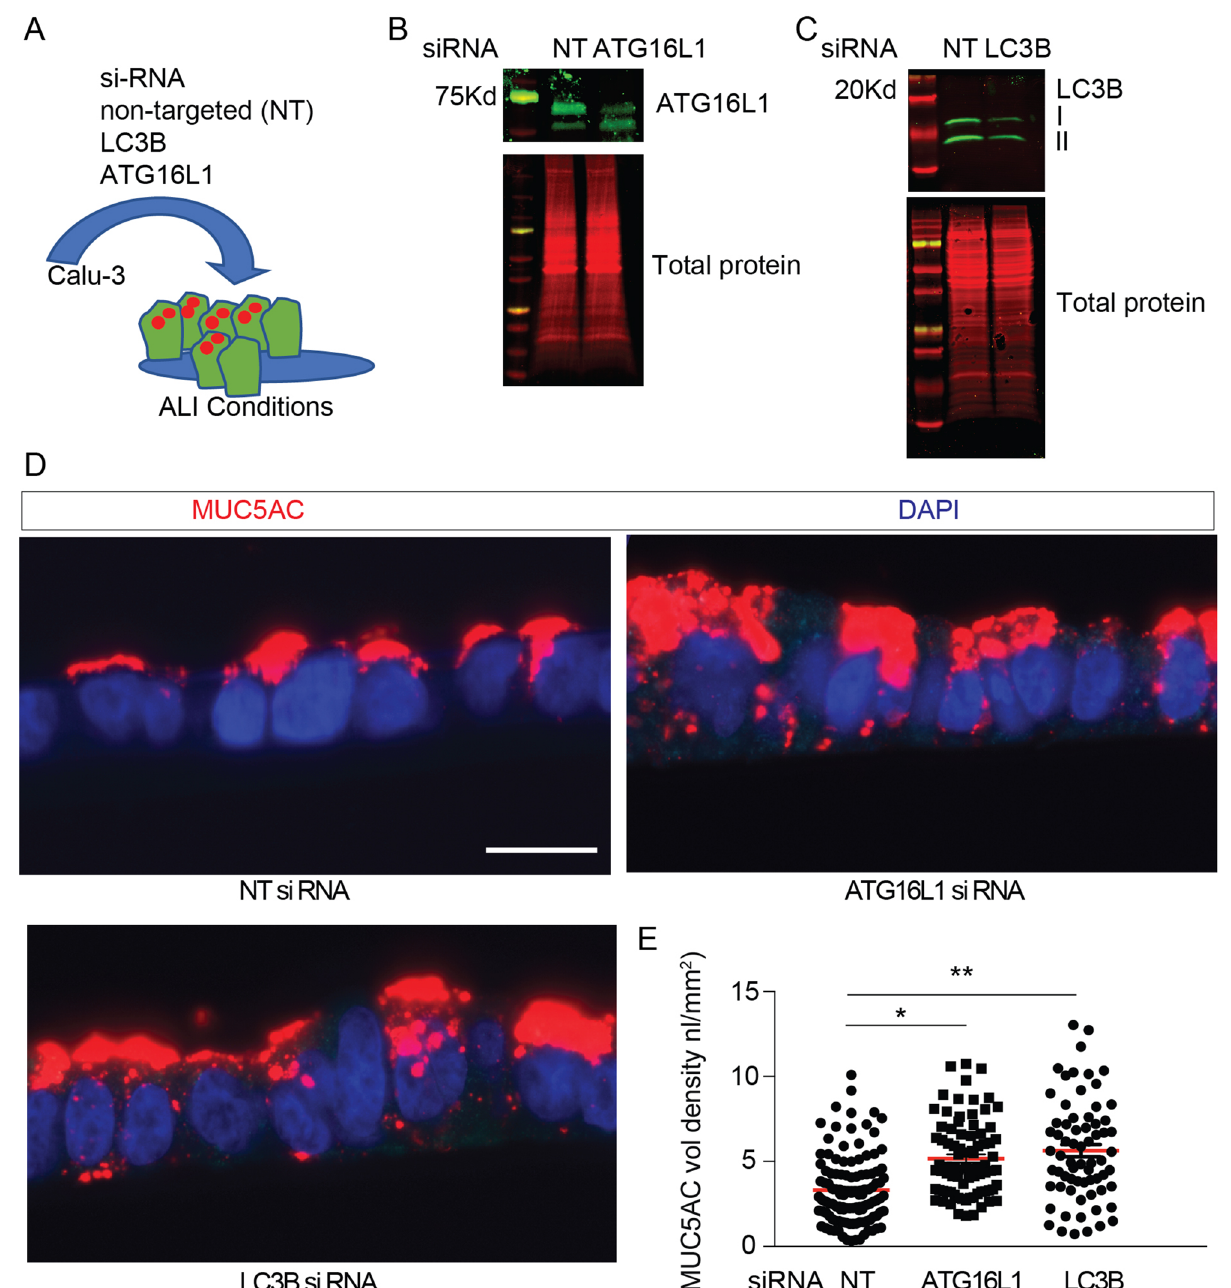
Figure 7. Autophagy deficient airway epithelial cells have increased intracellular MUC5AC granules. ( A ) Schematic for targeted depletion of ATG16L1 and LC3B levels in Calu-3 cells under ALI culture conditions. Representative immunoblots for Calu-3 cells transfected with non-targeted (NT), ATG16L1 siRNA ( B ) or LC3B siRNA ( C ). ( D ) Representative immunostaining using mouse anti-MUC5AC in Calu-3 cells transfected with non-targeted control (NT), LC3B, or ATG16L1 siRNA and corresponding quantification ( E ). Scale bar = 20 microns. (n = 3 experiments with 10–20 microscopic images per sample). Significant difference by ANOVA with Tukey’s post-hoc comparisons are noted by * NT vs Atg16L1 siRNA treatment difference or ** for NT vs. LC3B siRNA differences. Graphs show scatter plots with median bar for mucin